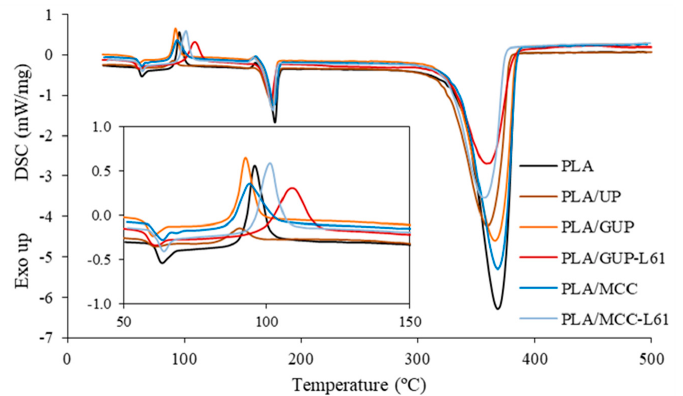
Figure 9. DSC curves of PLA and biocomposite films with the crystallization region in the insert (see Table 1 for abbreviations and Table 3 for composite composition). Table 4. DSC parameters for PLA and its biocomposite films (see Table 1 for sample identification). Sample